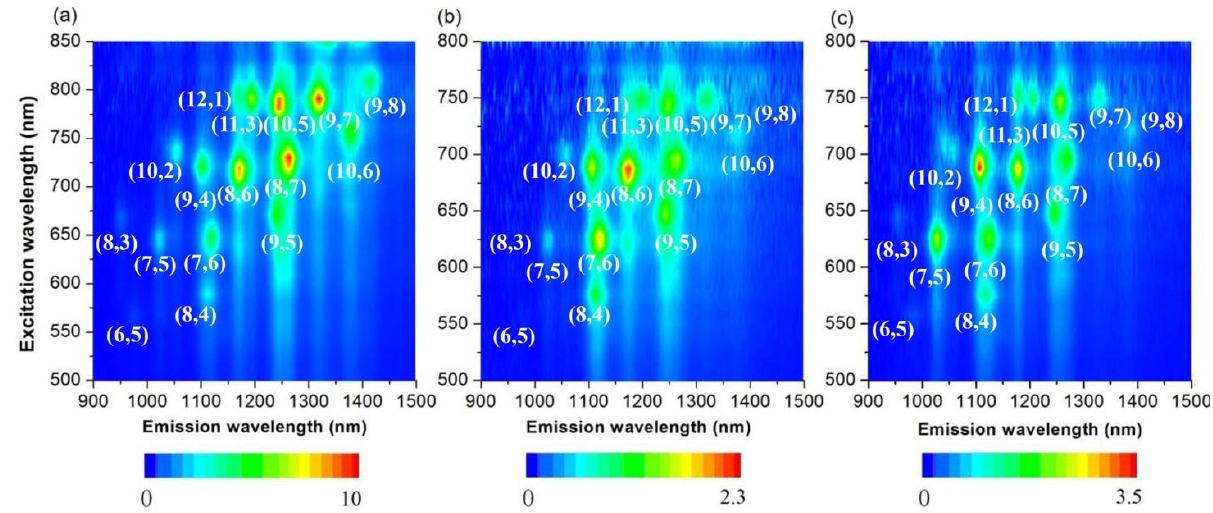
Figure 8. Photoluminescence spectra of D after extraction with ZnOEP ( b ) and MnOEP ( c ).